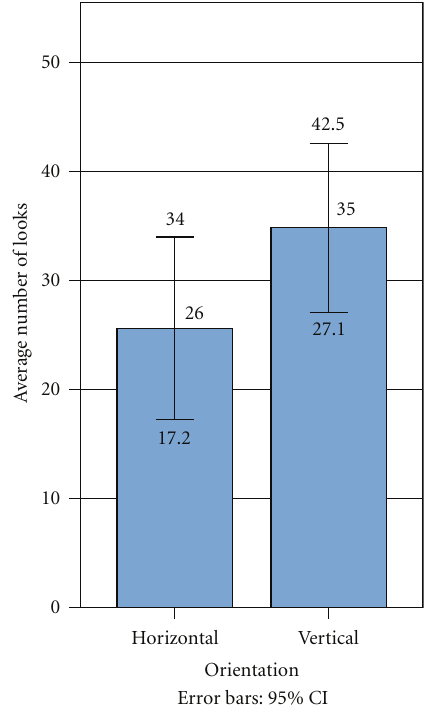
Figure 2: Average number of looks (per